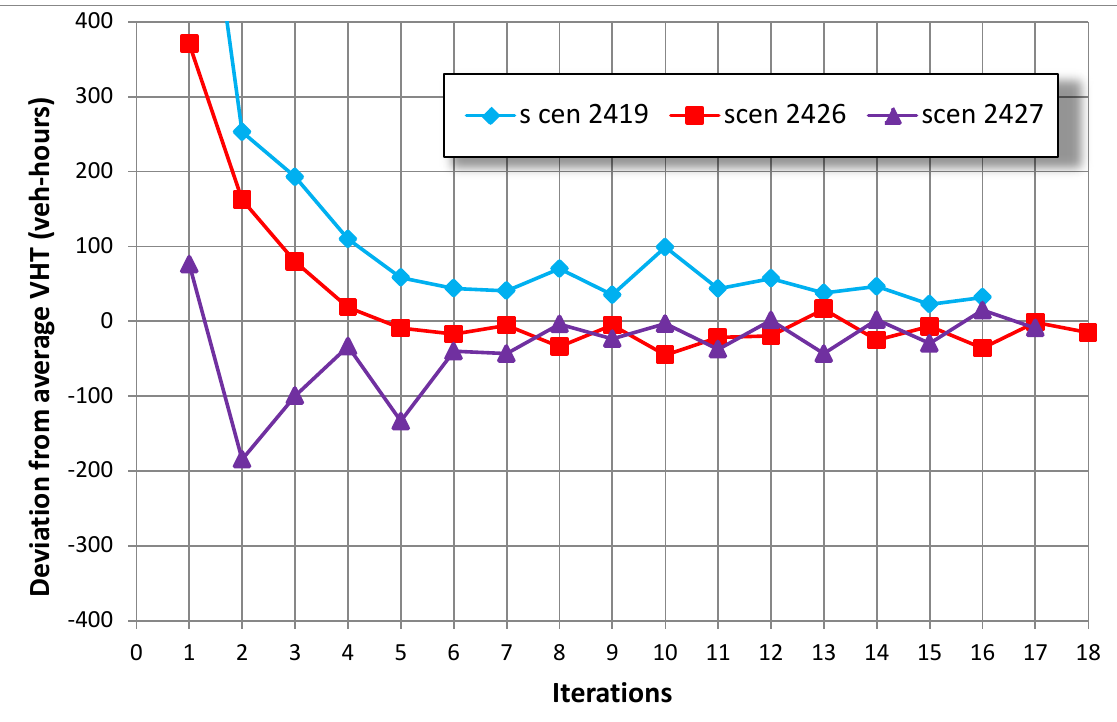
Figure 14. VHT convergence for “Quasi-aggregation” procedure